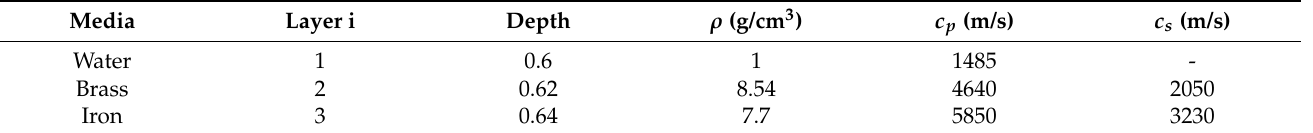
Table 3. Parameters of the marine environment.